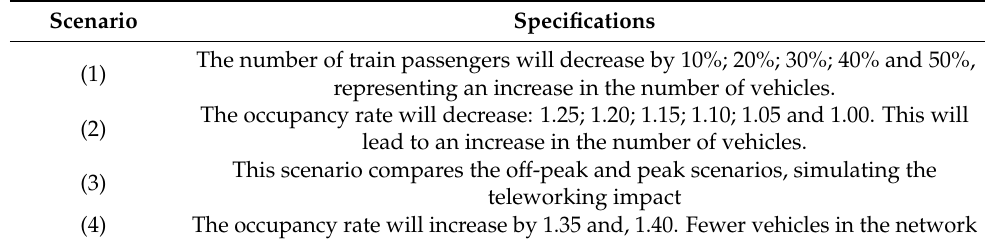
Table 1. Scenarios under study and their specifications.